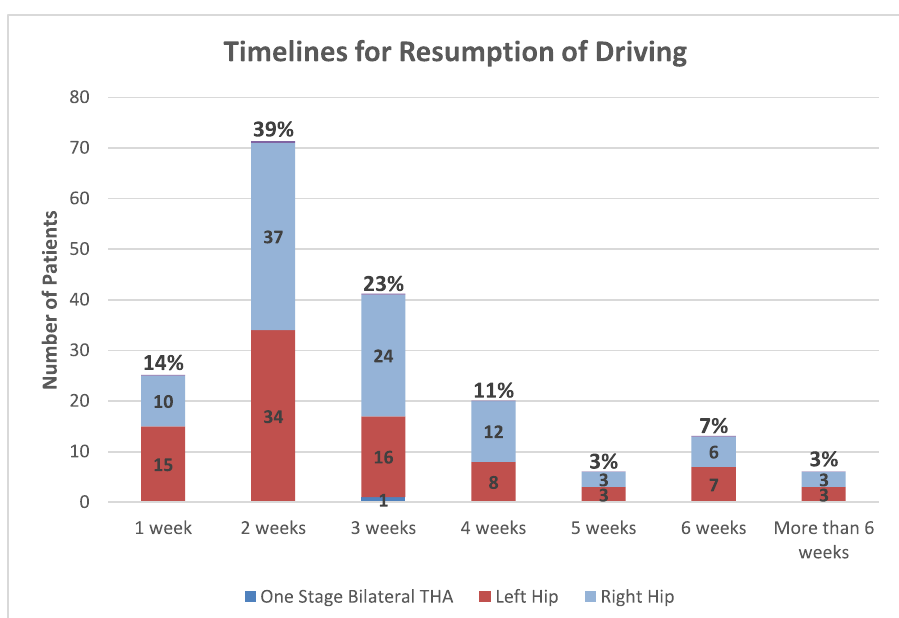
Figure 1. Patient timelines for the resumption of driving following BHA.